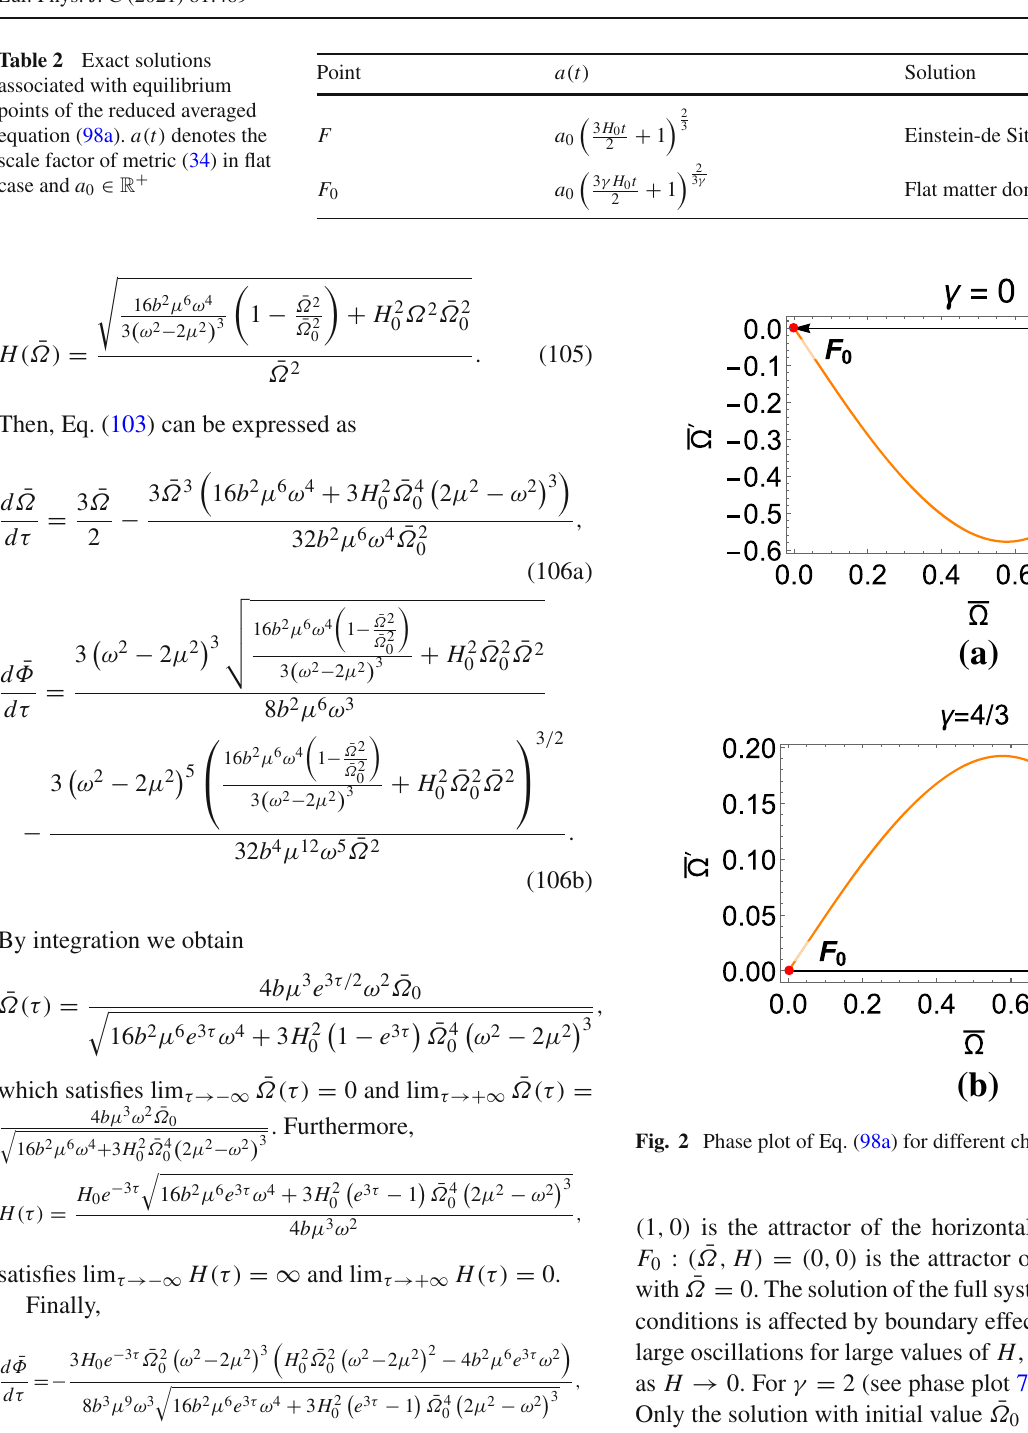
( 1 , 0 ) is the attractor of the horizontal line with ¯ Ω = 1. ¯ Ω, H ) = ( 0 , 0 ) is the attractor of the horizontal line F 0 : ( ¯ Ω = with 0. The solution of the full system with same initial conditions is affected by boundary effects at large oscillations for large values of H , but they are damped as H → 0. For γ = 2 (see phase plot 7d) the attractor is F . Only the solution with initial value